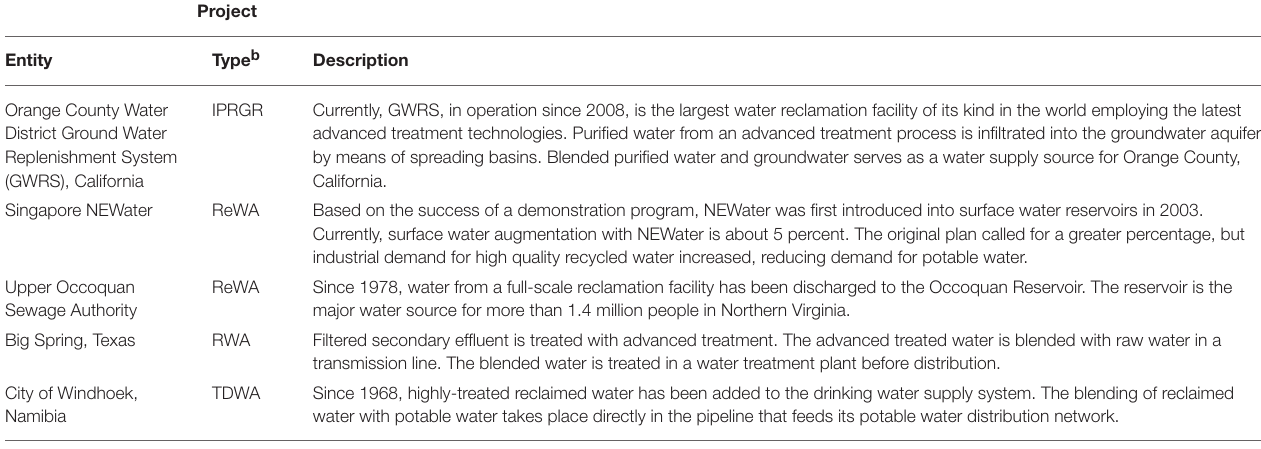
TABLE 6 | Representative examples of successful potable reuse projects a